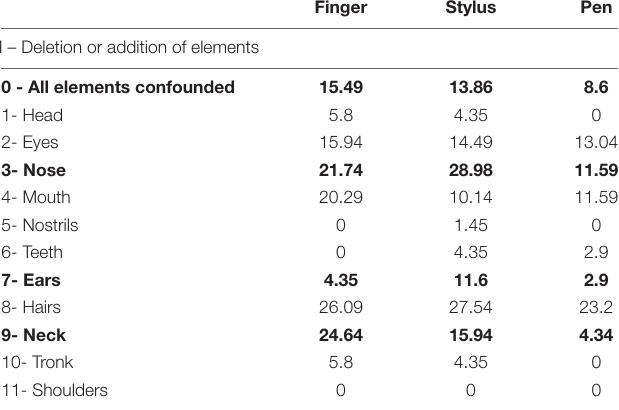
TABLE 4 | Occurrence (percentage) of each item of originality scale as a function of drawing condition (significant differences on Cochran’s Q test are in bold). Finger Stylus